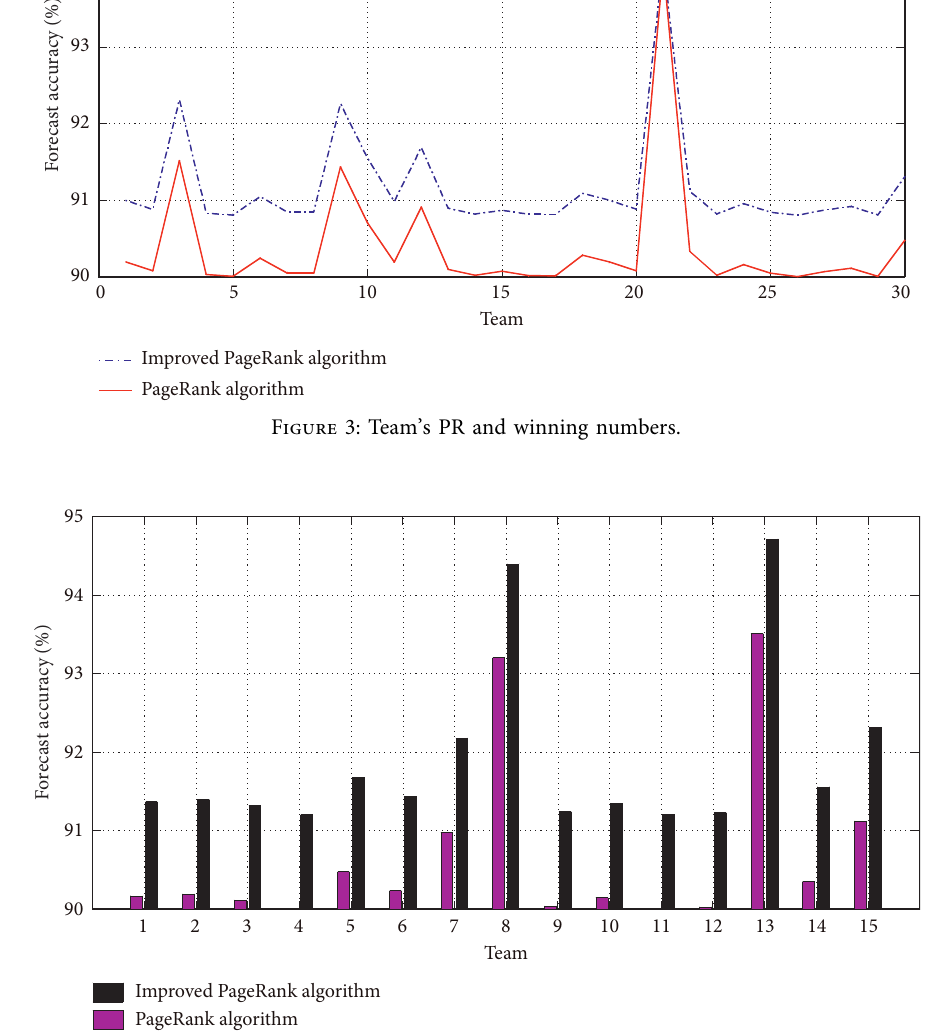
Figure 4: Team’s PR and winning numbers in the eastern